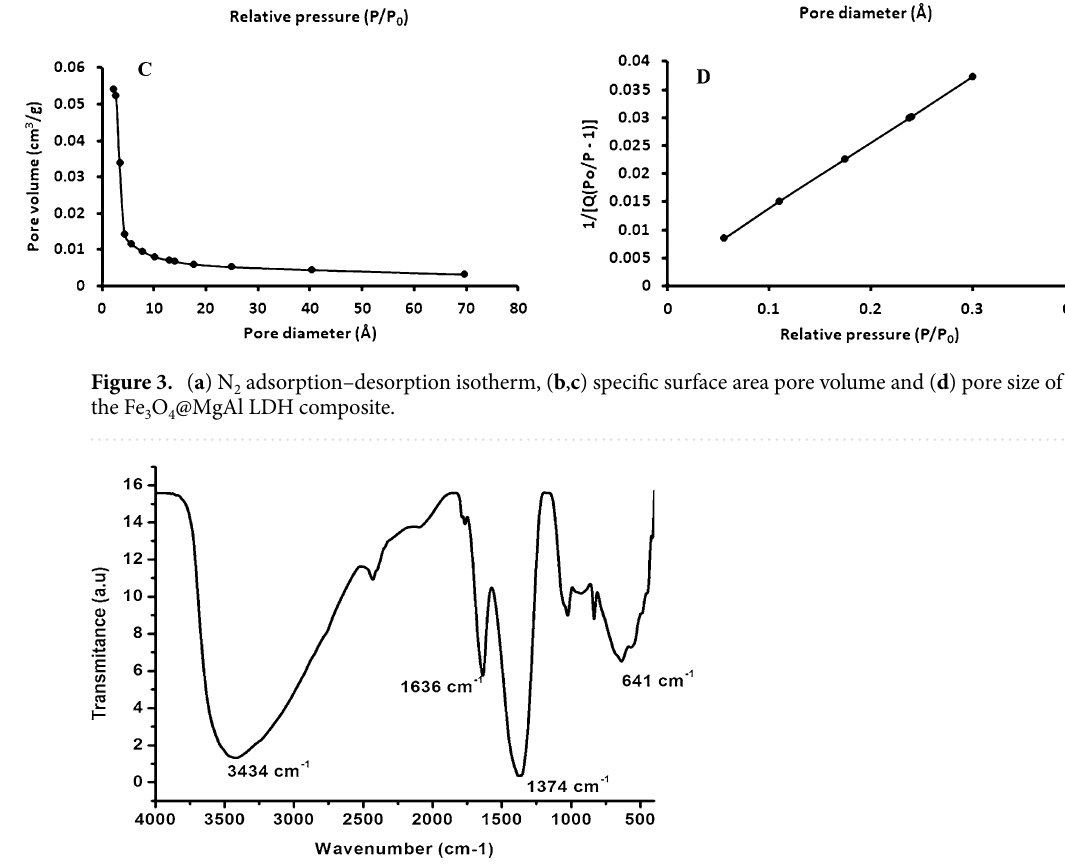
Figure 4. FTIR spectra of magnetic Fe 3 O 4 /MgAl LDH nanocomposite before and after